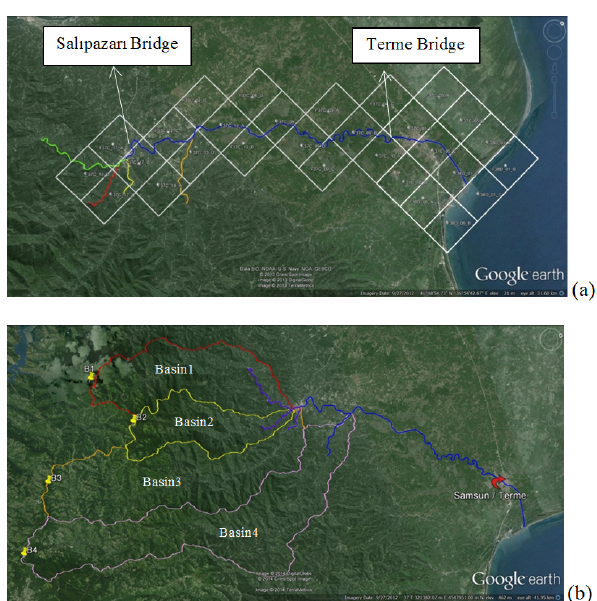
Figure 1. The river with upstream branches, 1 × 5000 − 1 scaled or- thophoto maps, location of two bridges (a) and the upstream sub basins (b)